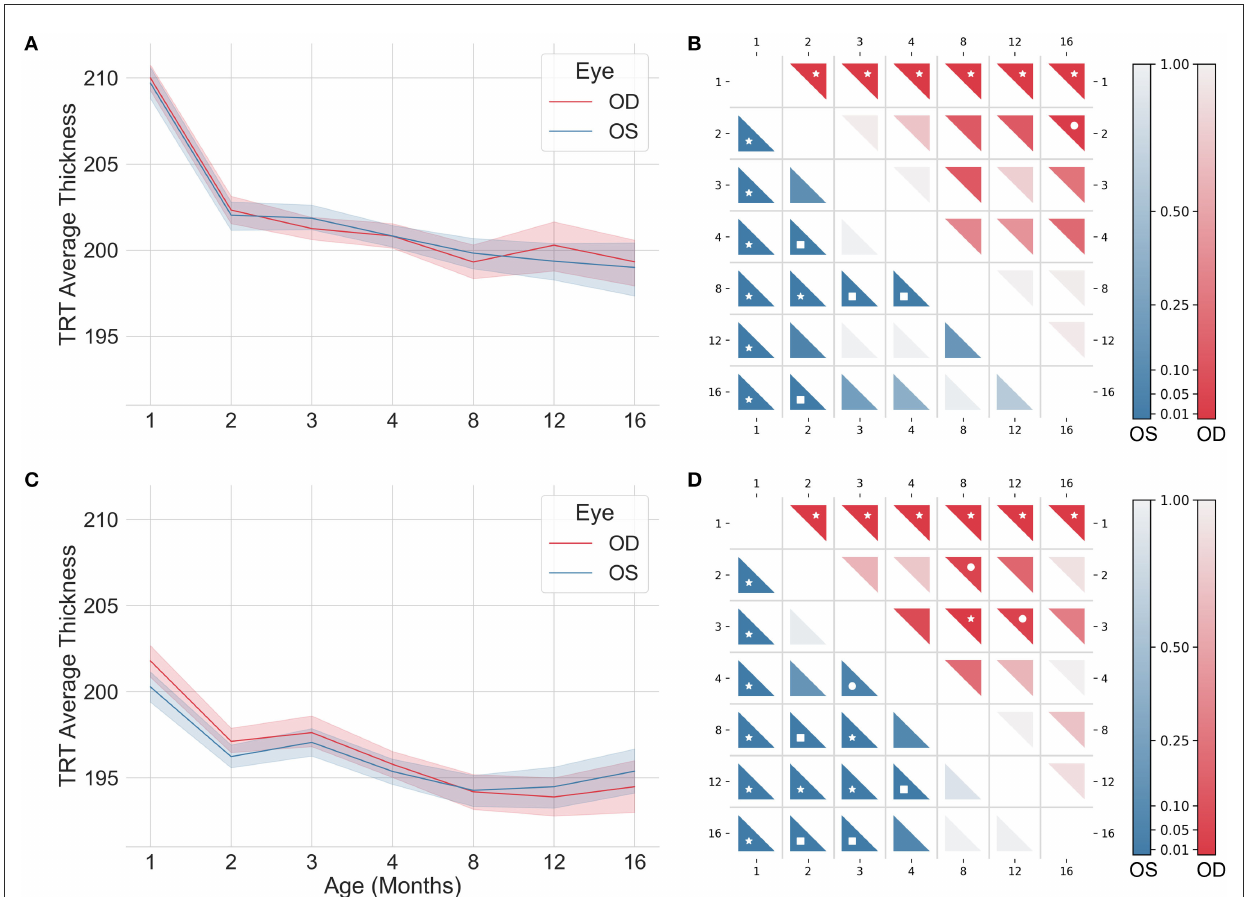
FIGURE5 Longitudinal total retinal thickness of wild-type (A, B) and the triple transgenic Alzheimer’s disease (C, D) mice for left (OS; blue) and right (OD; red) eyes. Color coded p -values for pairwise comparisons are shown in (B) and (D) . The color indicates the level of the p -value, as indicated by the color bars. p -values < 0.05 ( • ), < 0.01 ( (cid:4) ), and < 0.001